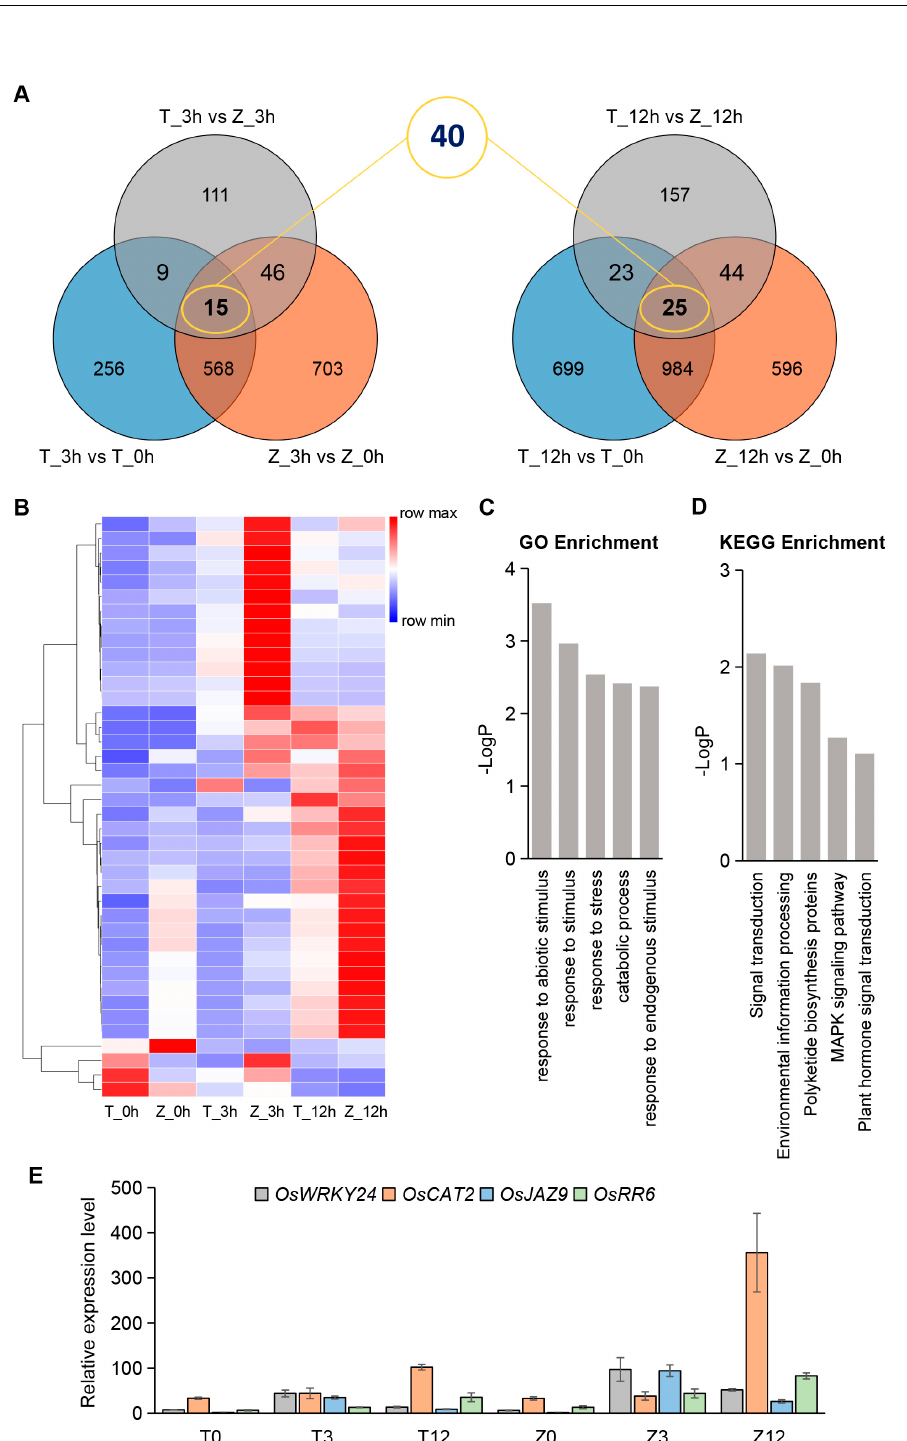
Figure 5. Identification and pathway analysis of core DEGs related to differential cold sensitivity between Towada and ZL31. ( A ) Venn diagram of DEGs at 3 and 12 h of cold treatment comparing Towada with ZL31. The number in the yellow circle represents the total DEGs of the two linked groups. ( B ) Hierarchical clustering of the 40 DEGs based on FPKM values in Towada and ZL31. ( C , D ) GO and KEGG pathway enrichment analysis of the 40 DEGs. The y − and x − axes represent the negative log 10 P value and the top 5 items with the most significant differences, respectively. ( E ) Relative expression levels of OsWRKY24 , OsCAT2 , OsJAZ9, and OsRR6 by qRT − PCR. All assays were performed with three biological and three technical replications. Error bars, mean + SE.